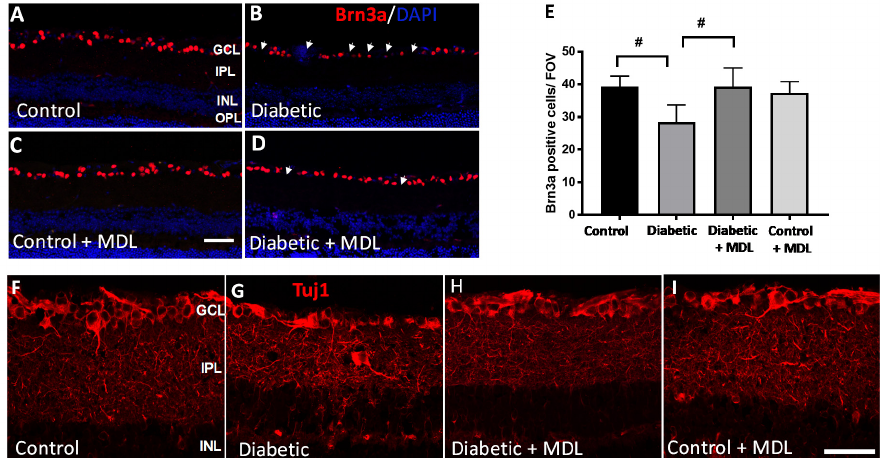
Figure 5. E ff ect of MDL 72527 treatment on diabetes-induced RGC loss. ( A – D ) Immunostaining of retinal cryostat sections using Brn3a antibody showing a reduced number of Brn3a positive RGCs in the diabetic retina (16 weeks), compared to control. Treatment with MDL 72527 improved the survival of Brn3a positive cells. ( E ) Quantitative analysis demonstrating significant loss of Brn3a-positive cells in the GCL in response to diabetes. Treatment with MDL 72527 protected against the diabetes-induced RGC loss. ( F–I ) Immunostaining using Tuj1 marker showing the axonal loss in diabetic retina compared to controls. MDL 72527 treatment reduced axonal degeneration in the diabetic retina. Treatment with MDL 72527 markedly improved Tuj1 levels in diabetic retina. N = 5–6 per group were included in the experiment and representative images are shown. Data are presented as mean ± SD. # p < 0.01. Scale bar 50 µ